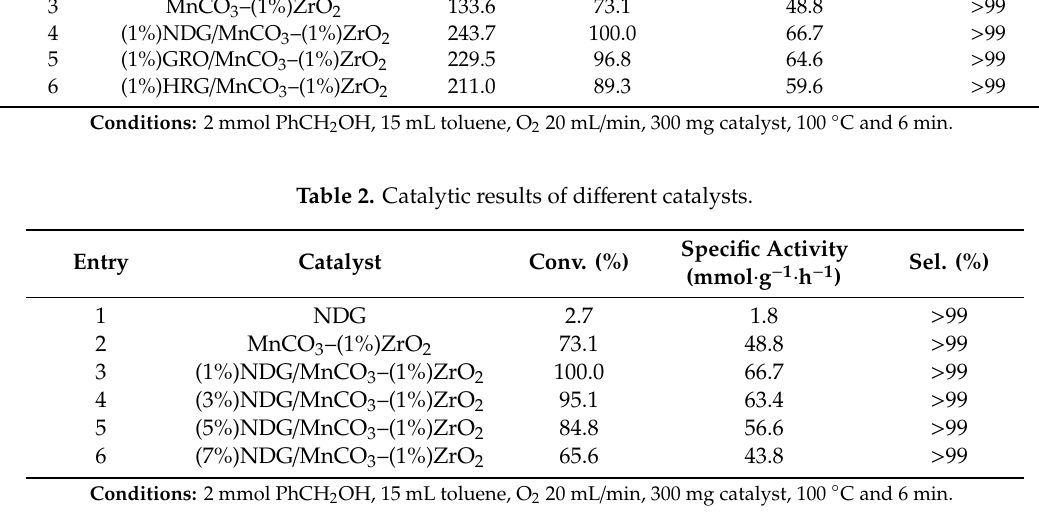
MnCO 3 –(1%)ZrO 2 and ( c ) (1%)NDG/MnCO 3 –(1%)ZrO 2 catalysts.